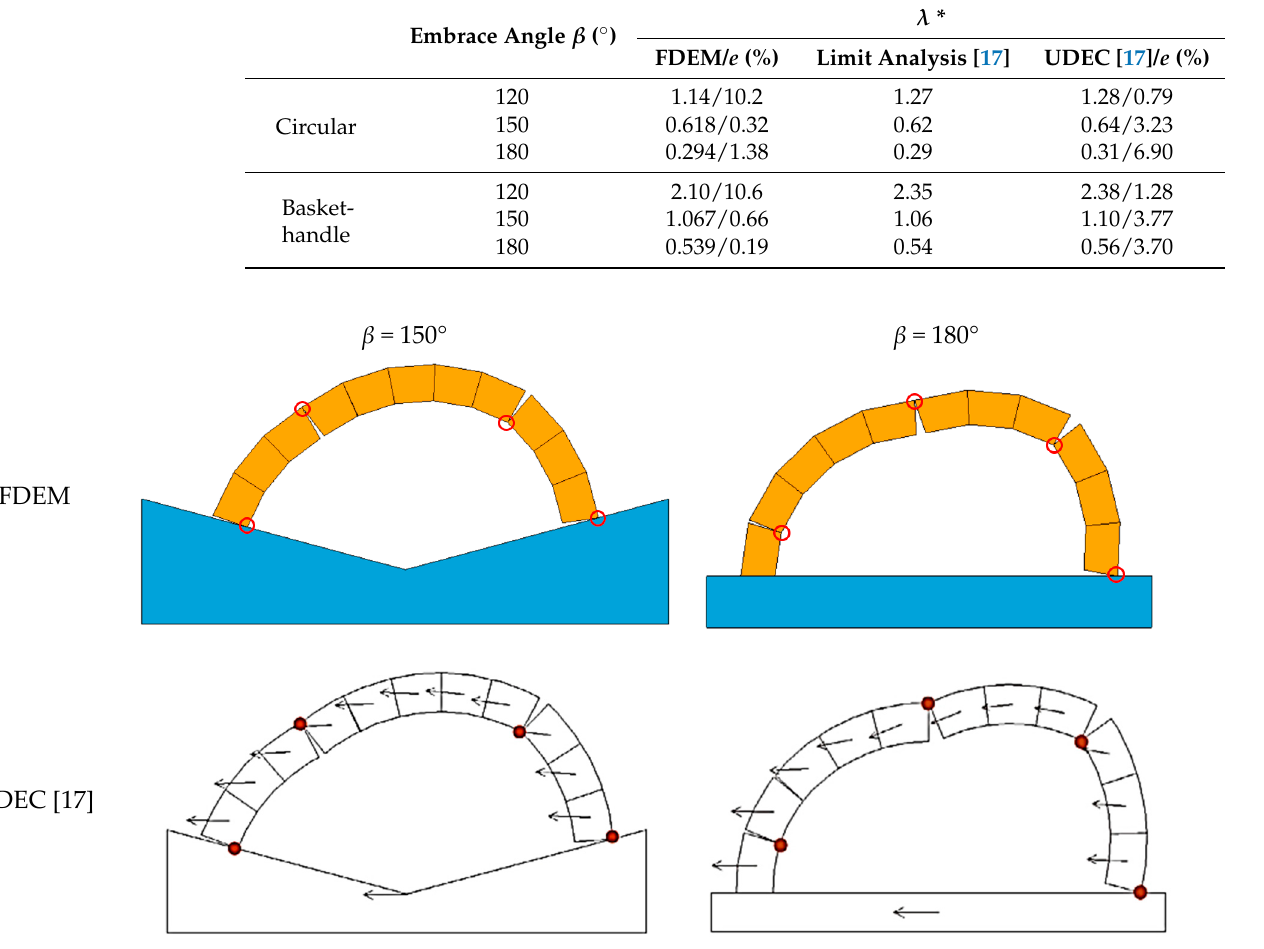
Table 2. λ * of circular and basket-handle arches without buttresses.